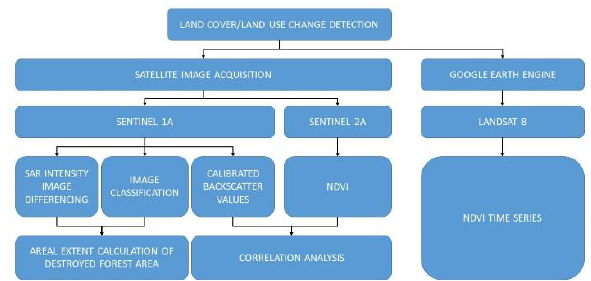
Figure 4. The process flow chart of the study.